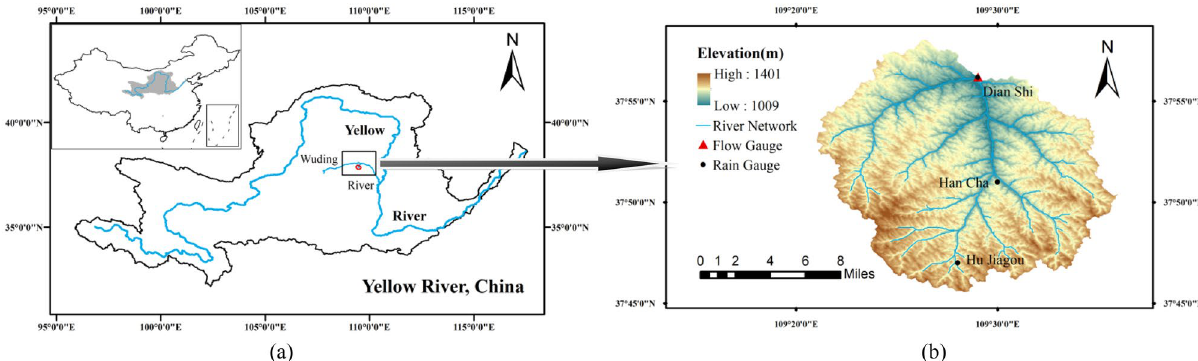
Figure 1. Location of the study area and stations (map generated using ArcMap 10.4(10.4.1) 50 using ASTER GDEM digital elevation model 30 m resolution 51